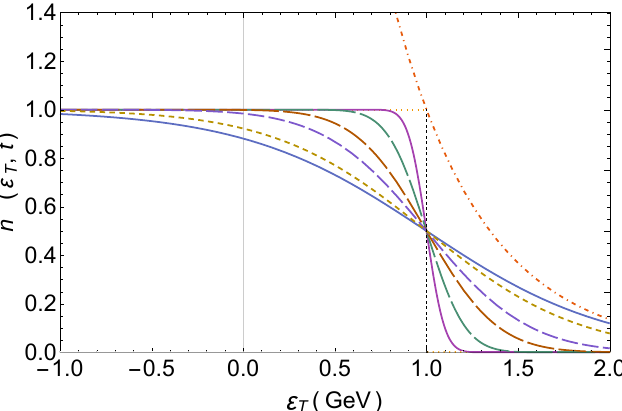
Figure 4. Occupation-number distribution n − ( (cid:101) T , t ) of a relativistic fermion system (valence quarks) as function of the transverse energy (cid:101) T including antiparticle production ( (cid:101) T < 0 ) . It is evaluated analytically from Equation(4) at different times for the initial distribution n − The parameters are µ = 1GeV, T = − D / v = 500MeV, τ − eq = 4 D / v 2 = 0.9 fm/ c . The distribution n − ( (cid:101) T , t ) is displayed at t = 0.003, 0.015, 0.06, 0.15, and 0.6 fm/ c (ordered by decreasing dash length towards the solid equilibrium distribution). The upper dot-dashed curve is Boltzmann’s distribution. The negative-energy region corresponds to antiparticle production. From